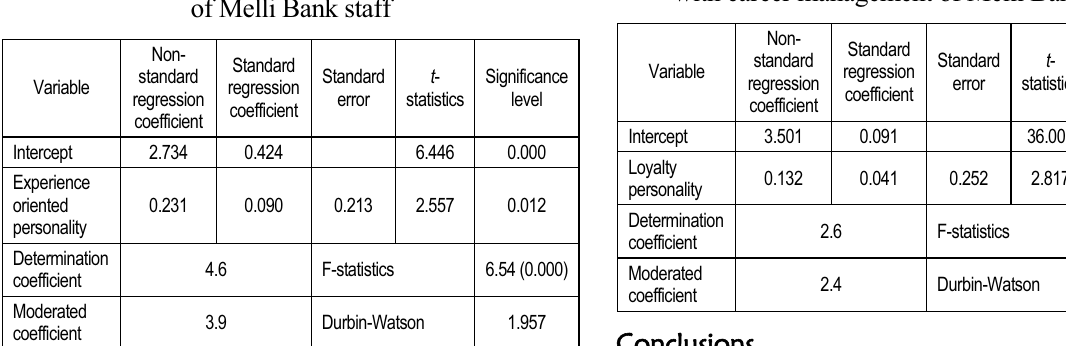
Table 3. Experience-oriented personality has a significant relation with career management